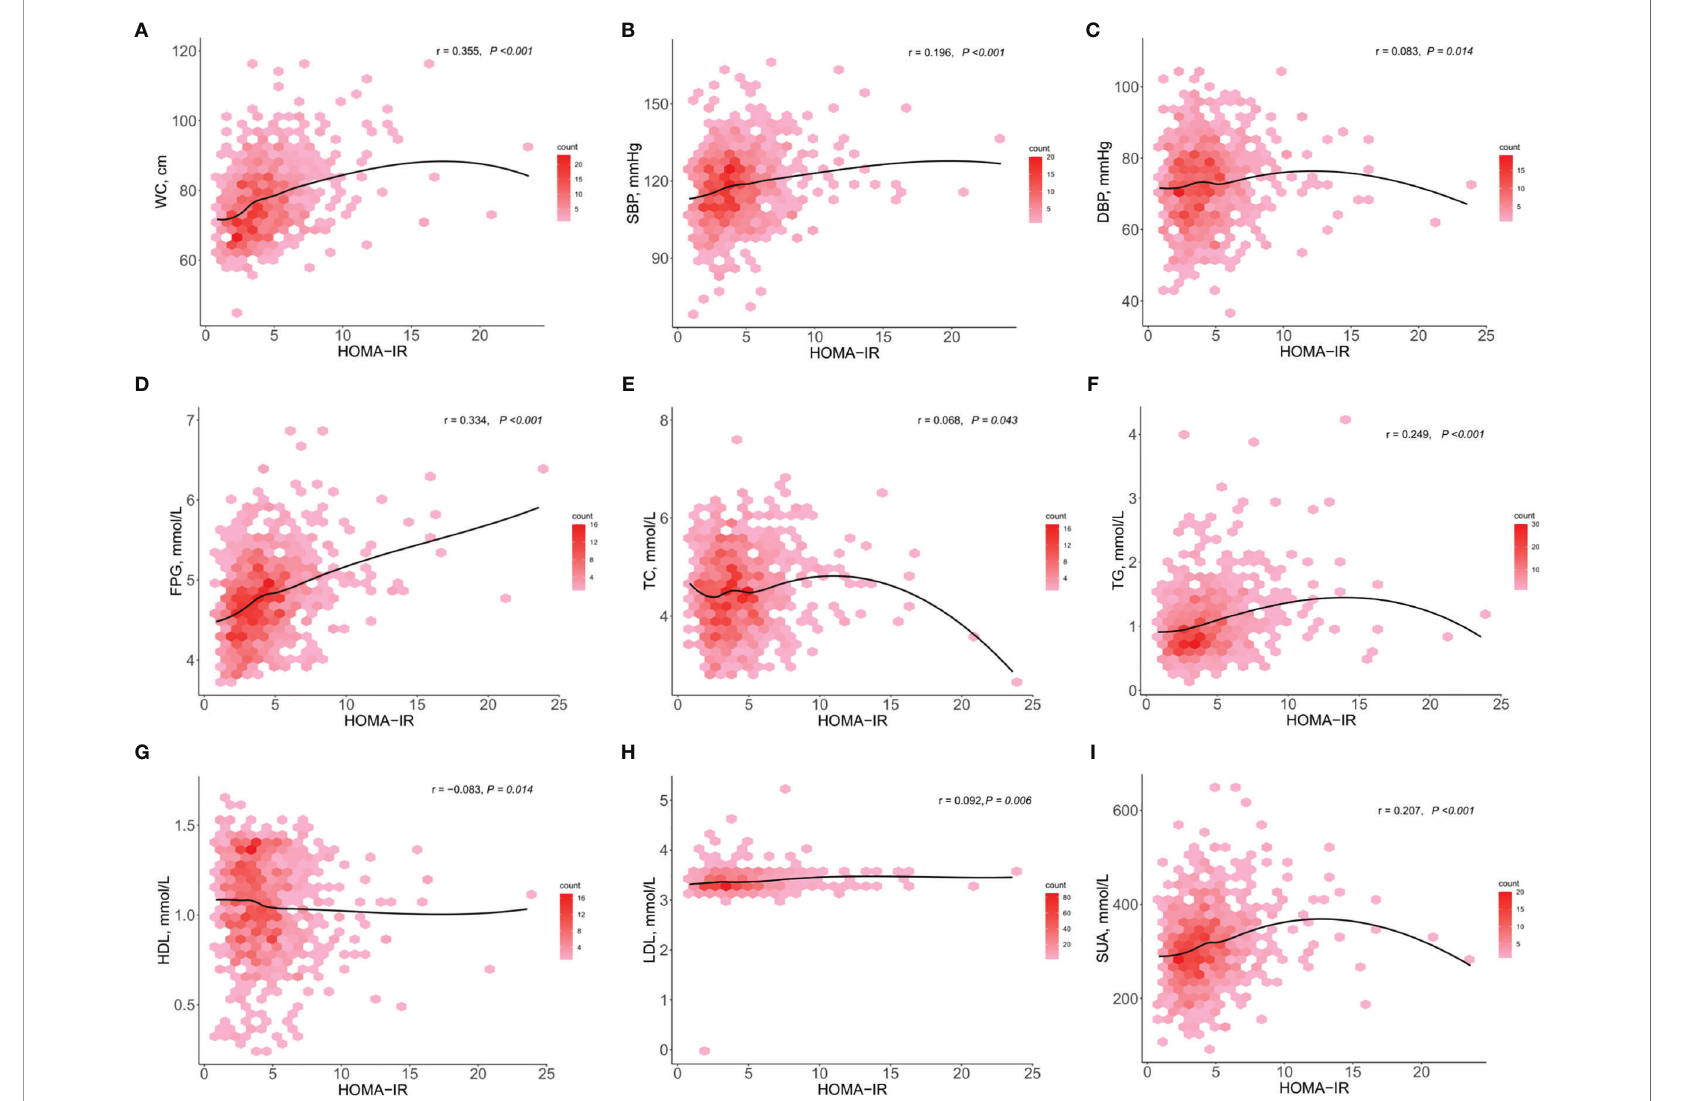
FIGURE 1 | Scatterplots of the homeostasis model assessment of insulin resistance against cardiometabolic risk factors (n = 882). Partial correlation coef fi cient of the HOMA-IR with WC, SBP, DBP, FPG, TC, TG, HDL, LDL, and SUA (A – I) , adjusted for age and sex. Darker red denotes higher density. The black line is a smoothed condition mean, denoting the mean value of the cardiometabolic risk factor at a given HOMA-IR. DBP, diastolic blood pressure; FPG, fasting plasma glucose; HDL-C, high-density lipoprotein cholesterol; LDL-C, low-density lipoprotein cholesterol; SBP, systolic blood pressure; SUA, serum uric acid; TC, total cholesterol; TG, triglycerides; WC, waist